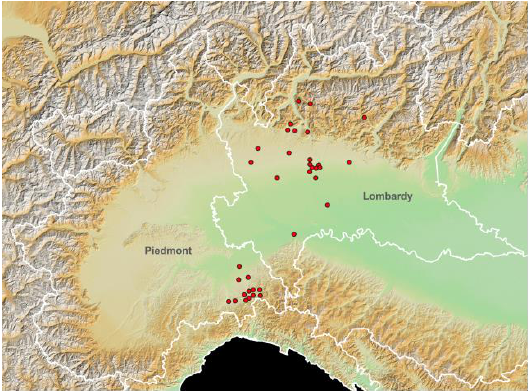
Figure 1. Study area elevation map (European Digital Elevation Model (EU-DEM), version 1.0; https://land.copernicus.eu/imagery-in-situ/eu-dem/eu-dem-v1-0-and-derived-products/eu-dem- v1.0?tab=metadata#:~:text=http%3A//land.copernicus.eu/pan-european/satellite-derived-products/eu-dem/eu-dem-v1-0-and-derived-products/eu-dem-v1.0/view; accessed on 15 November 2021) and spatial distribution of the tested horse stables (red dots). White lines: Italian regional boundaries.